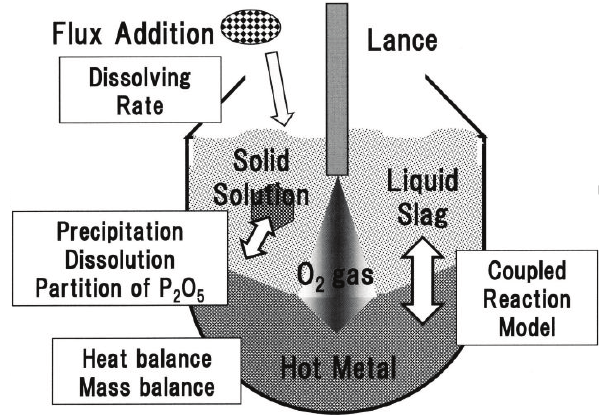
Figure 6. Outline of dephosphorization model.